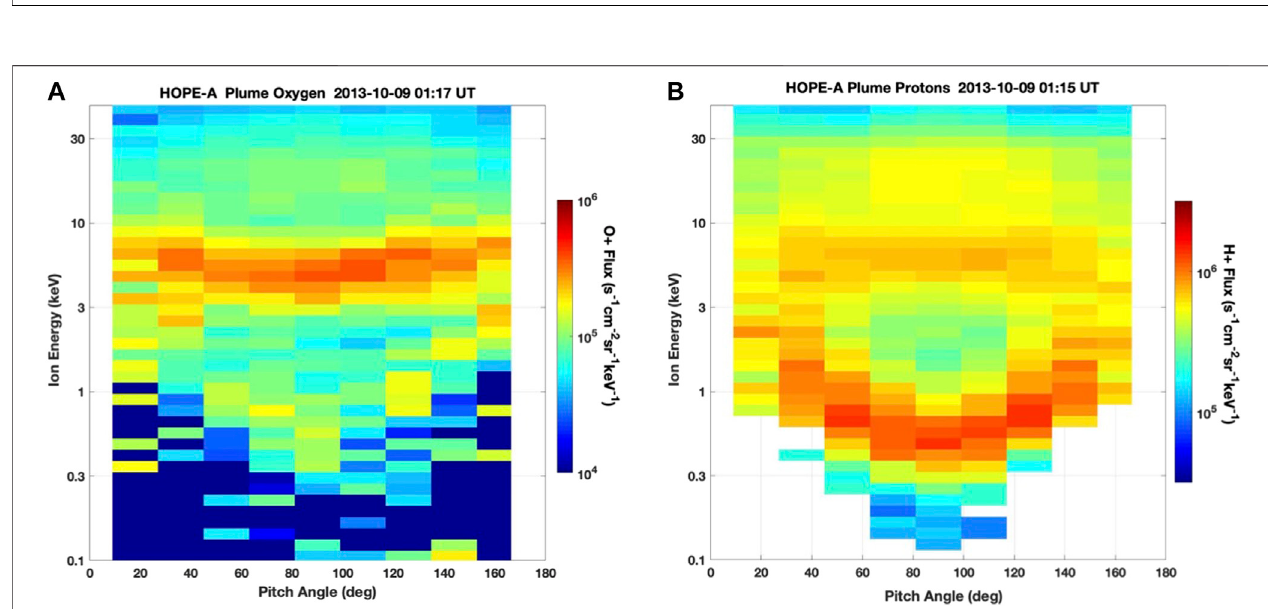
FIGURE6| IonPADs forO+ (A) and H+ (B) areshown for theRBSP-A plume crossing onOctober9,2013atthe time (at ∼ 01:15 UT)shown byverticalblacklines in Figure 5A,B . (A) O+ with energies < 1 keV was not observed on plume fi eld lines, while at higher energies O+ fl uxes moved toward a bi-directional fi eld aligned con fi guration as energy increased from 1 to 10 keV. (B) Strong 200 eV – 3 keV proton fl uxes were also observed in this region with similar con fi gurations in pitch angle, moving to ward bi-directional fi eld alignment with increasing energy. At higher energies 1 – 10 keV, H+ exhibited a butter fl y PAD.